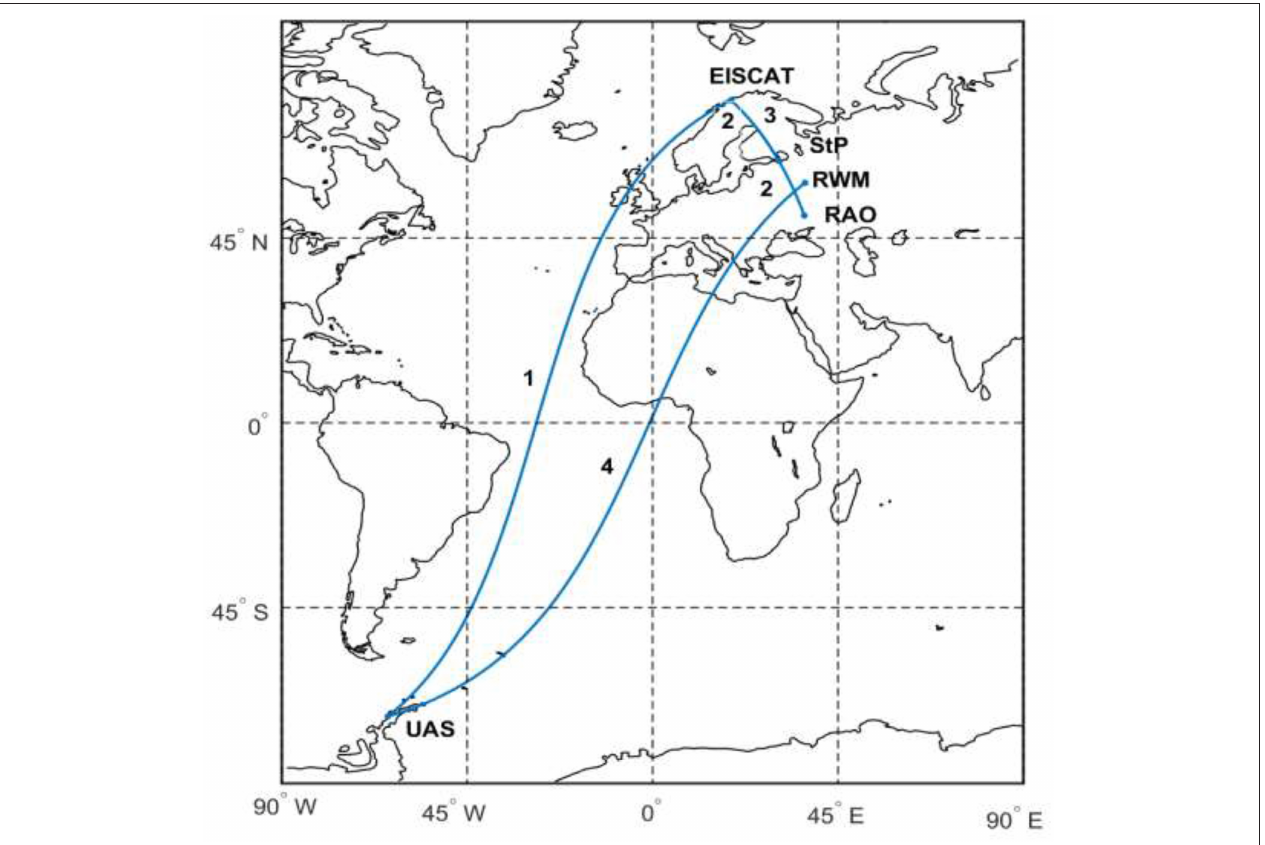
FIGURE 2 | Layout of the experiment. 1: radio path Tromso–UAS (16,300km); 2: radio path Tromso–RAO (2,400km); 3: radio path Tromso–StP (1,200km); 4: radio path RWM–RAO (15,900km).